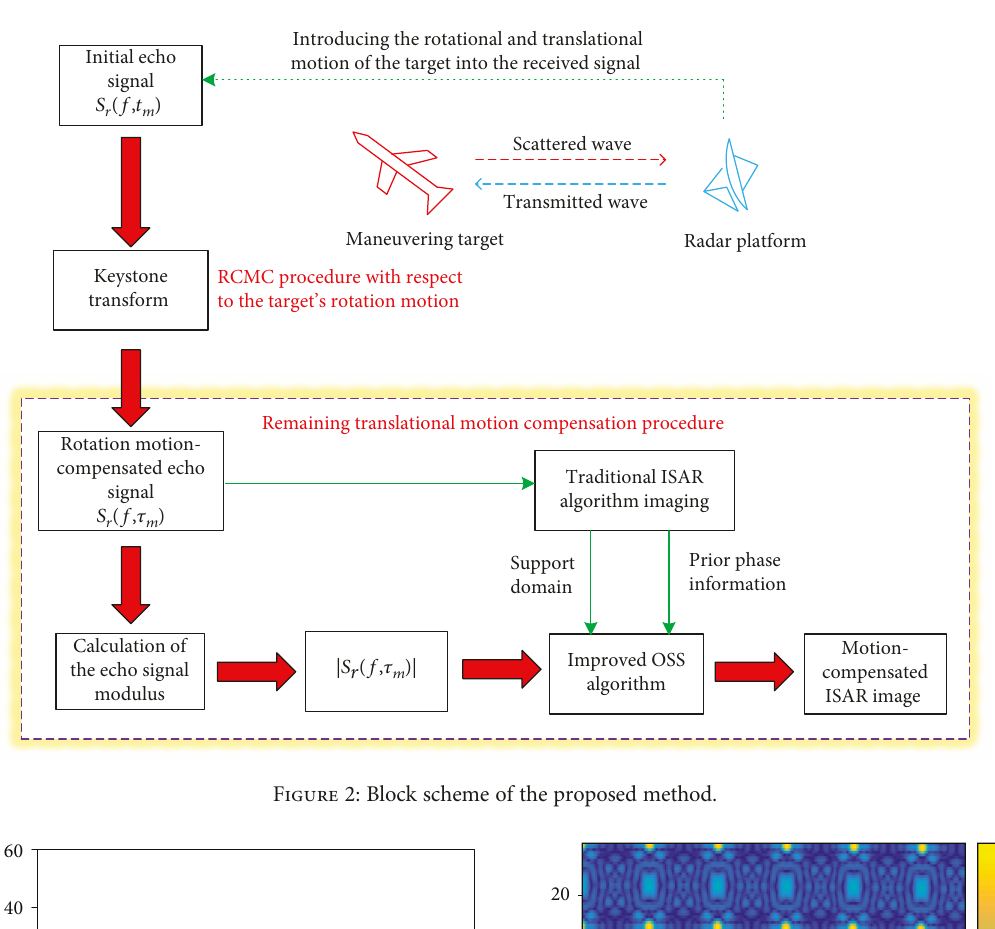
Figure 2: Block scheme of the proposed method.